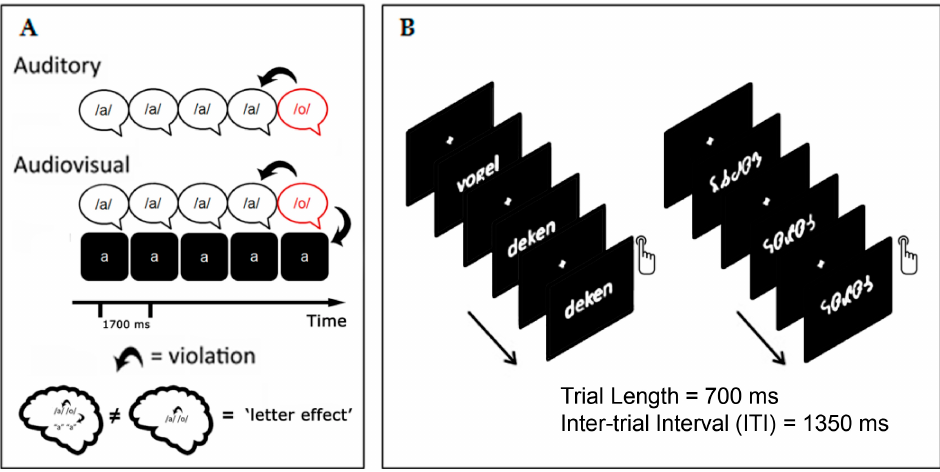
Figure 1. Crossmodal MMN paradigm ( A ); and visual word recognition paradigm consisting of a one-back task with words and symbol strings ( B ).